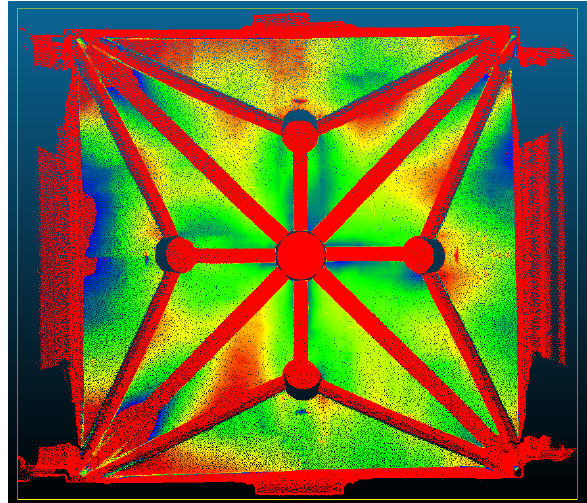
Figure 9. Chromatic scale showing the distances between the point cloud and the surface from the algorithm. The reddish color values show a positive shift (up) compared to the NURBS point cloud, while the chromatic values in blue show the negative deviations (downwards).